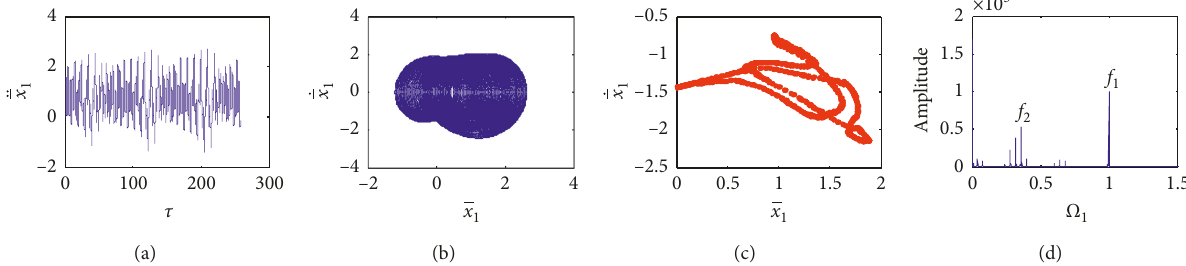
Figure 11: Vibration characteristics when Ω � 1.9: (a) time domain, (b) phase diagram, (c) Poincar´e section, and (d) frequency domain. 1